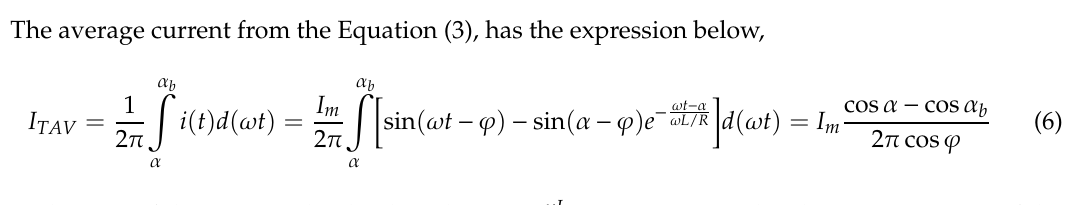
Figure 2. Current and power loss variation in time ( I = 200 A, R = 1.4 Ω , L = 30 mH, α = 60 °el.).